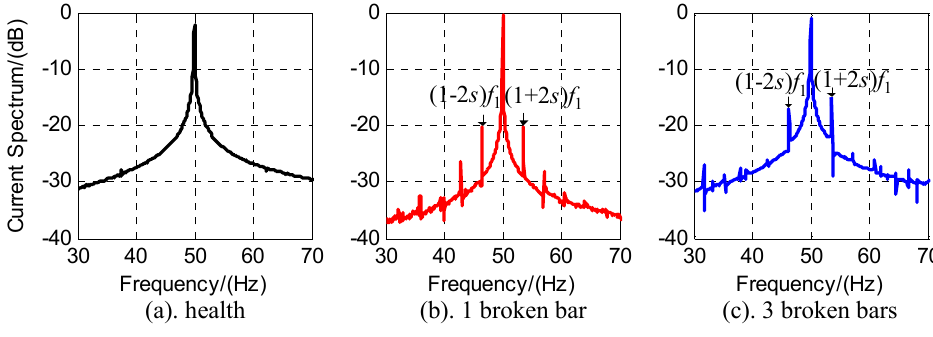
Figure 24. Current spectrums under rotor faults.